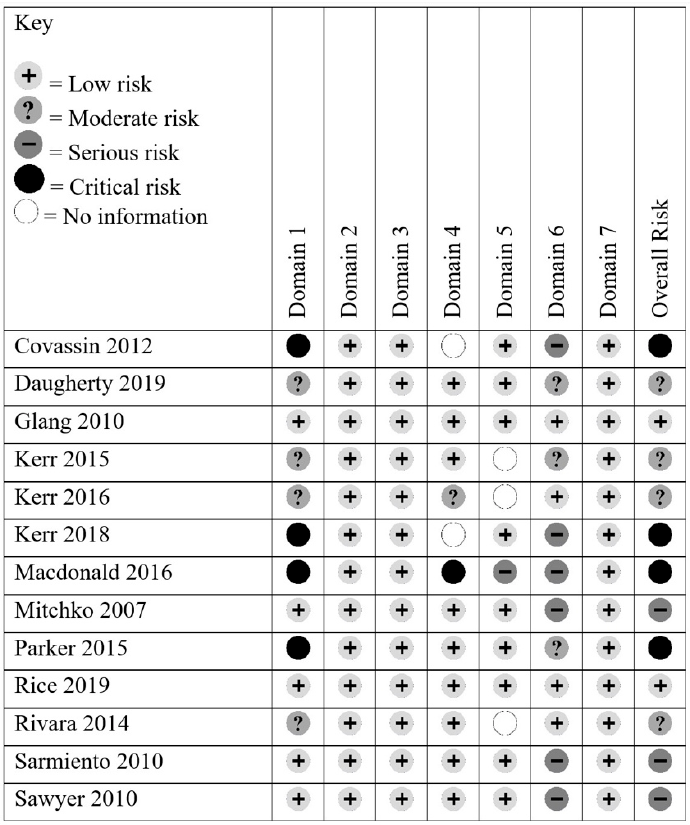
Figure 2. Risk of bias summary graph.